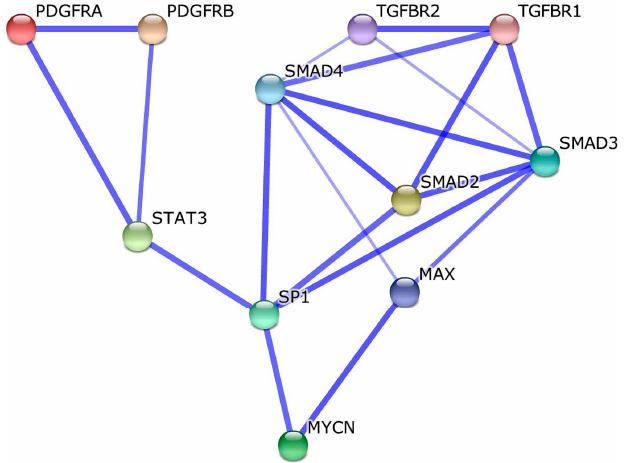
Figure 8. Identification of molecular pathways linking PDGFC (platelet derived growth factor C) and TGFB1 (transforming growth factor β 1) to MYCN (MYCN proto-oncogene, bHLH transcription factor). A meta-analysis of the human interactome was performed to determine whether signaling pathways could link MYCN (a known repressor of NDRG1 expression) to the identified candidate IL17D, IL33, IL12A, PDGFC and TGFB1. Data show that PDGFRA (platelet derived growth factor receptor α , a PDGFC receptor) and TGFBR1 (transforming growth factor β receptor 1, a TGFB1 receptor) are second shell interactants of MAX (Myc associated factor X) and SP1 (Sp1 transcription factor), two transcription factors that are recruited by MYCN during the transcriptional repression of specific target